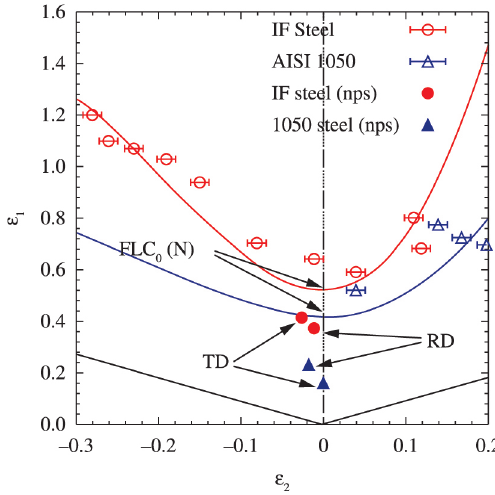
Figure 2. Results from the Near Plane Strain tests (nps), solid symbols, compared with the traditional Nakazima’s test (N) results (empty symbols). The estimated FLC value for Nakazima’s test 0 is indicated for both steels. The lines are drawn just as a guide to the